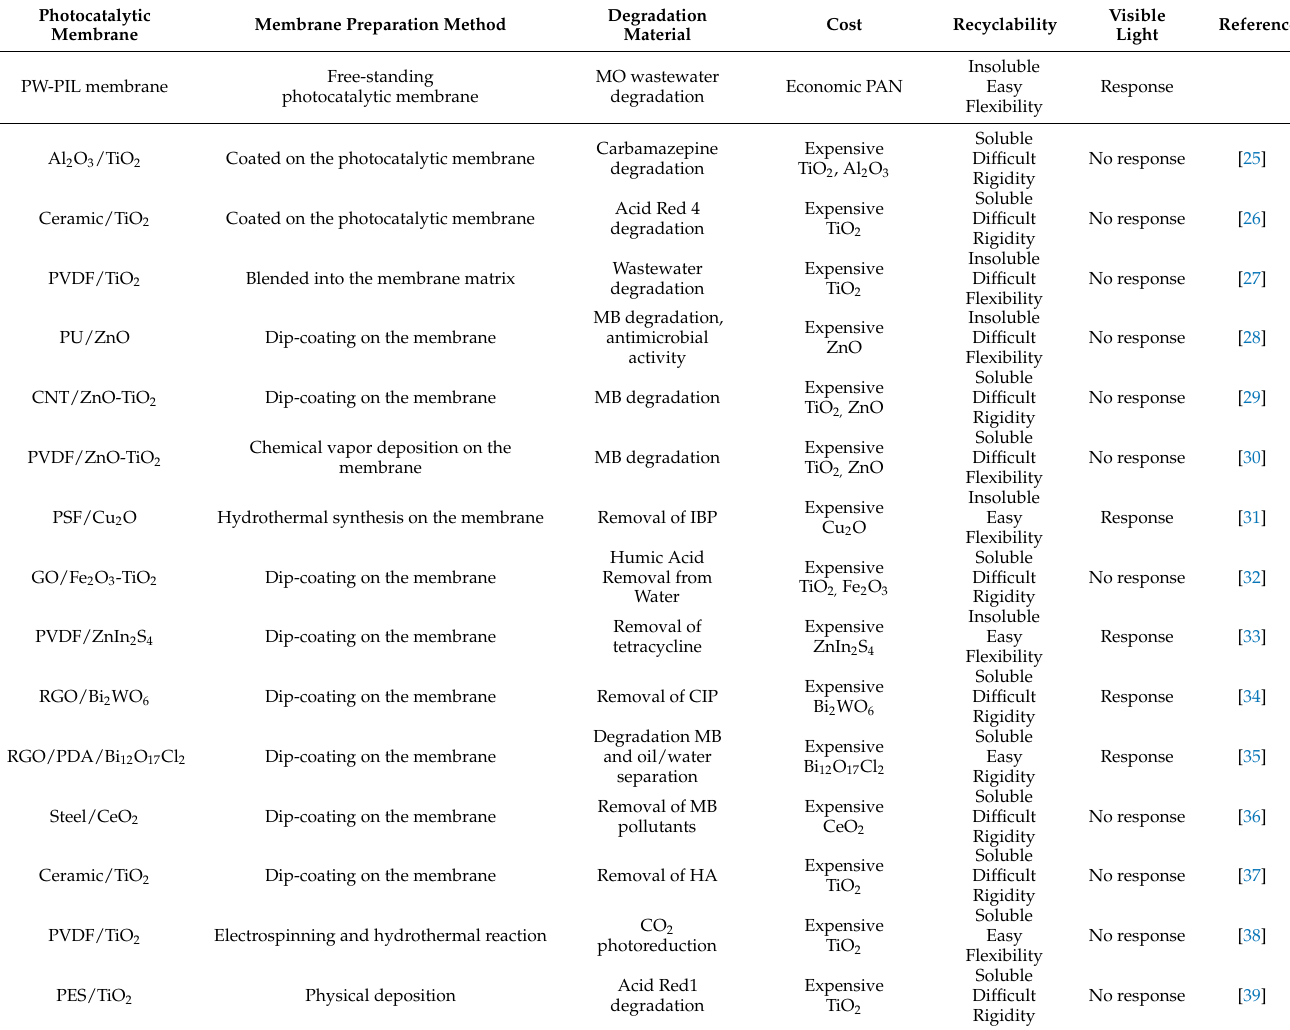
Table 1. The development of photocatalytic membrane